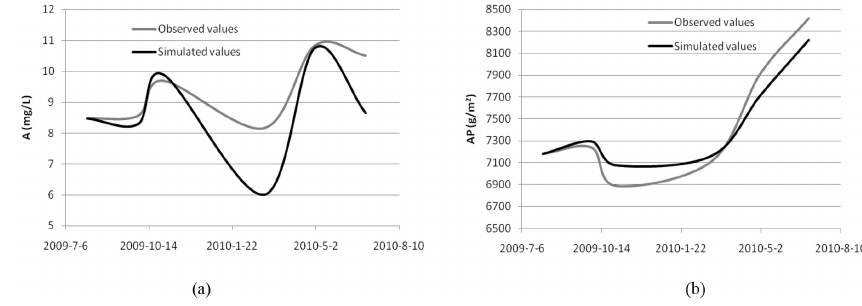
Figure 14. Calibration results for phytoplankton biomass (a) and aquatic plant biomass (b) at site 4.